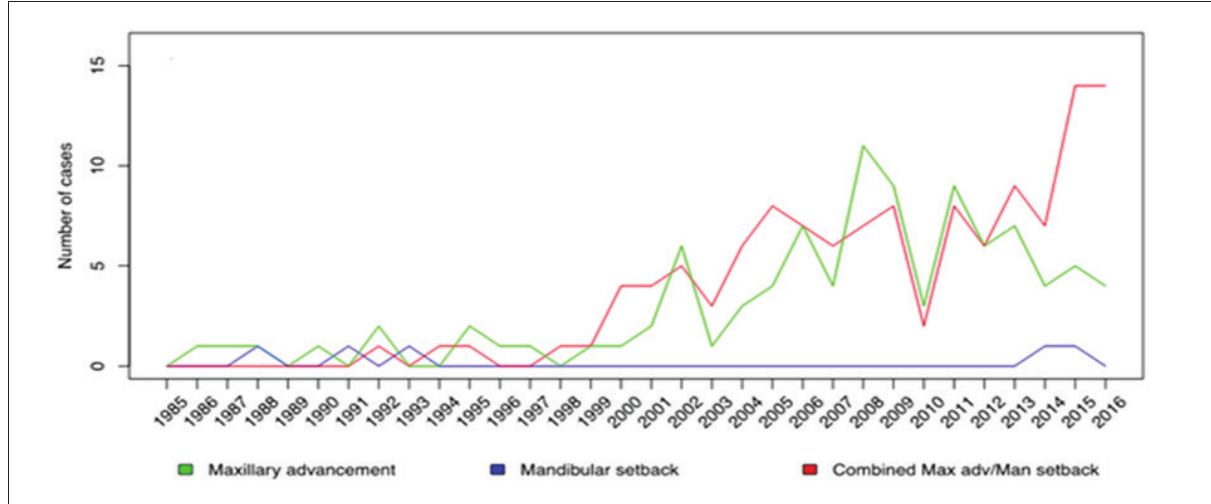
Figure 2. Frequency of surgery type in the treatment of Class III malocclusion between 1985 and 2016 in Western Australia.